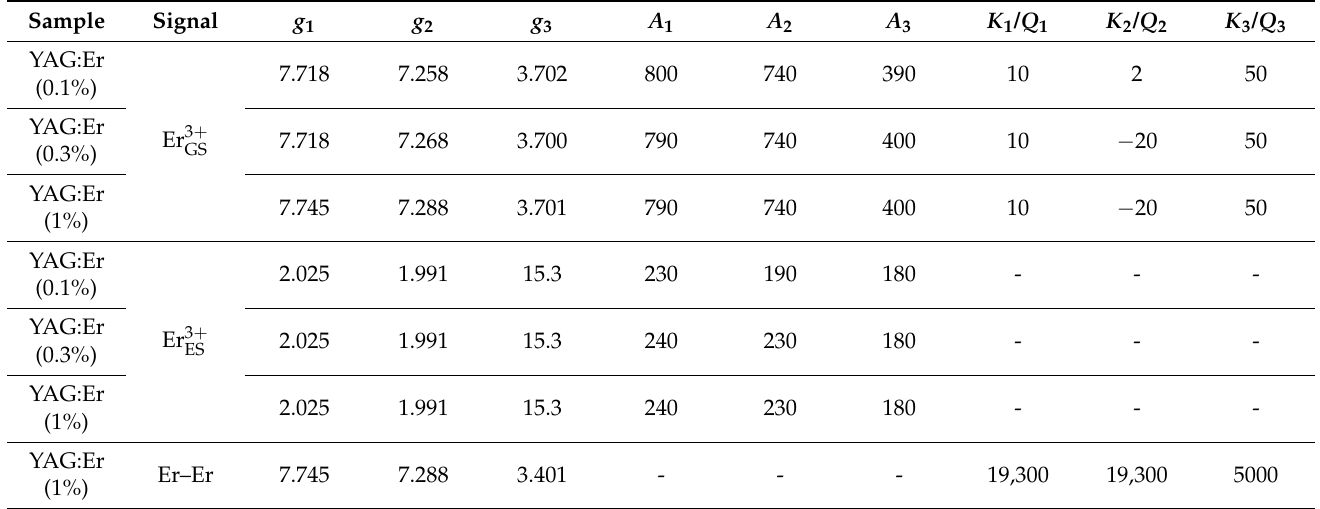
(Equation (2)) are close to those reported previously for Er 3+ in